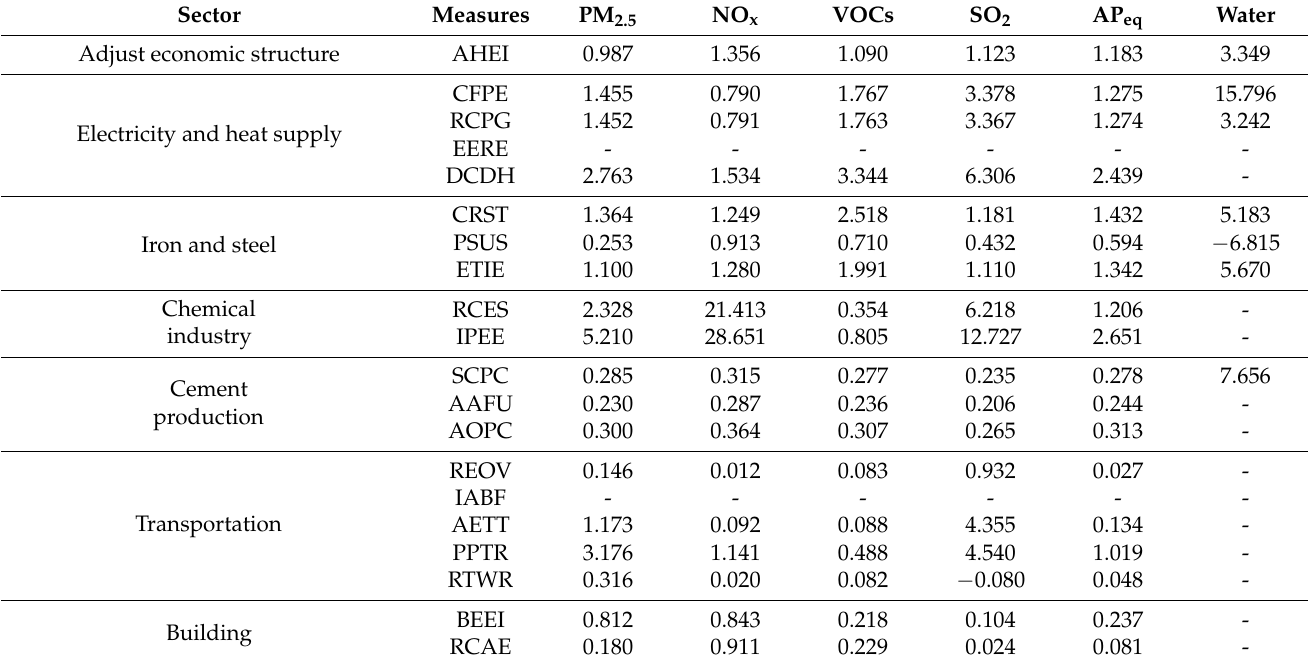
Table 5. ESI of CO 2 –air pollutants and CO 2 –water by the proposed measures in